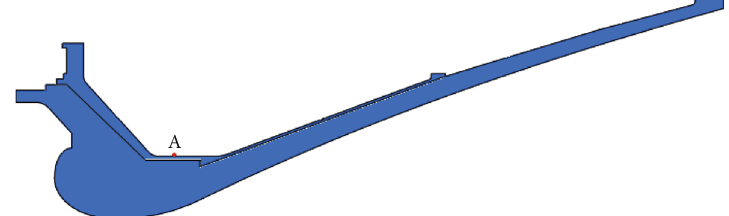
Figure 10: Temperature and strain measurement points of the motor ground test.